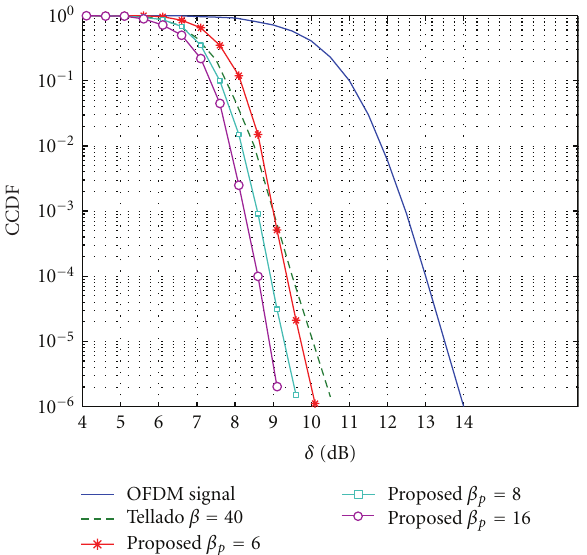
Figure 18: PAPR CCDF for IFFT-based TR and the algorithm in [16] for various values of β p , with L = 32 and β =